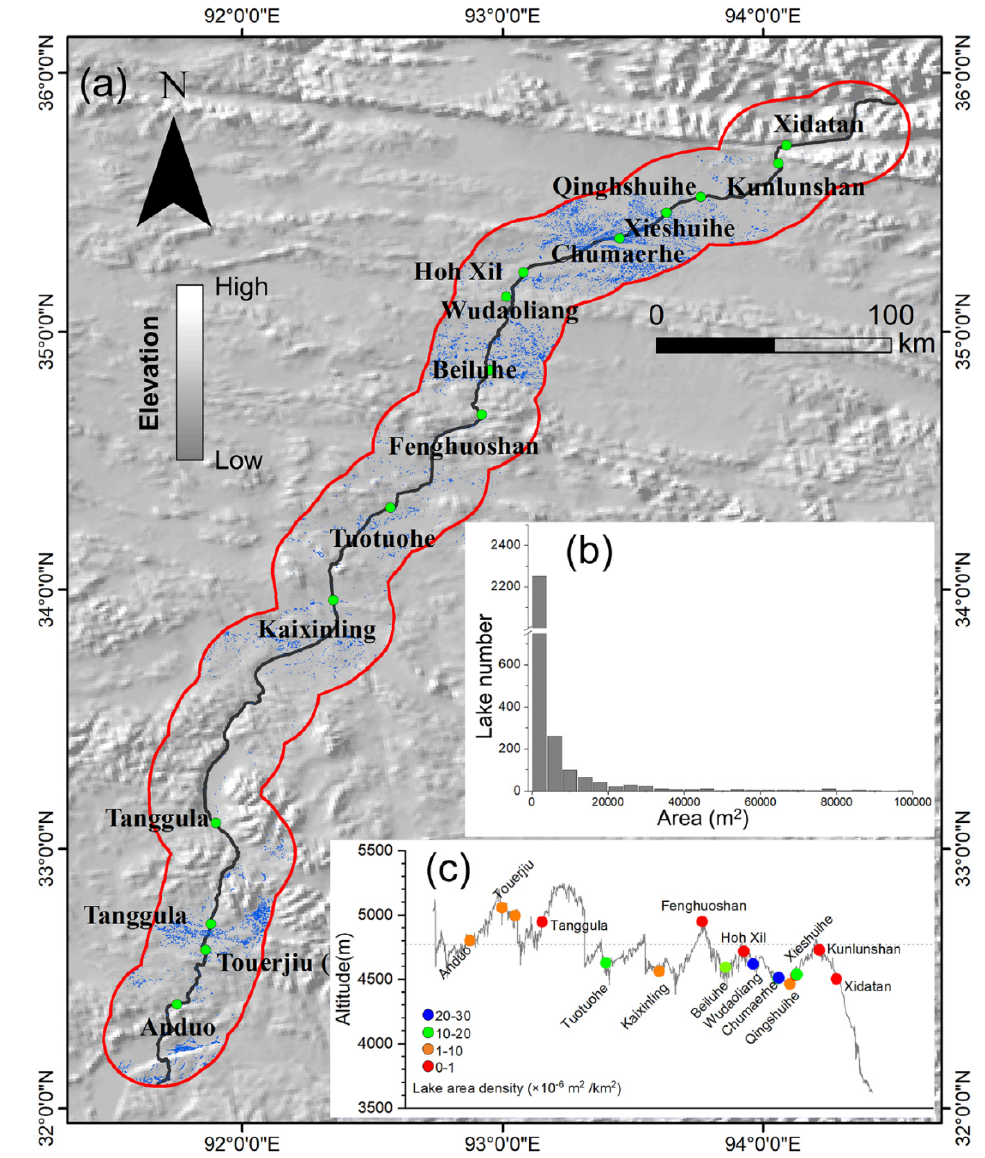
Figure 4. Spatial distribution of thermokarst lakes (TLs) on the territory: ( a ) overview of the TLs distribution in the QTEC; ( b ) histogram of the area of all TLs in the study area; and ( c ) section of the study area with the lake area density per 1 km 2 and the elevation. Background hillshade is from the elevation model (DEM).